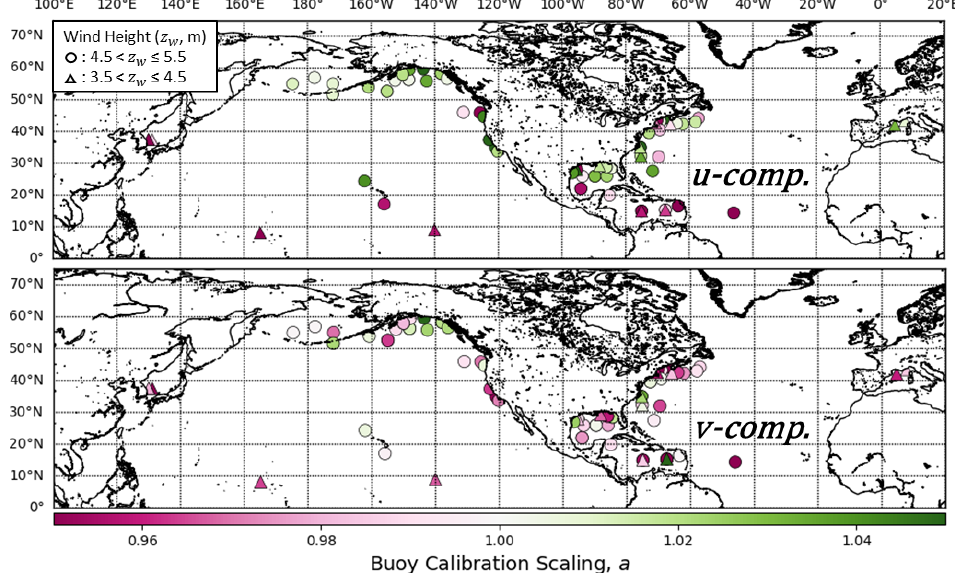
Figure 12. Triple collocation calibration scalings ( a ) of buoy U 10 S components calibrated with ASCAT winds as the standard for wind-wave-dominated seas ( β i > 1) at the individual buoy level. The top subplot shows the calibration scalings for the u-component ( a ubuoy ) and the bottom is the v -component scalings ( a vbuoy ). Point shapes correspond to the buoy anemometer height ranges shown in the legend.